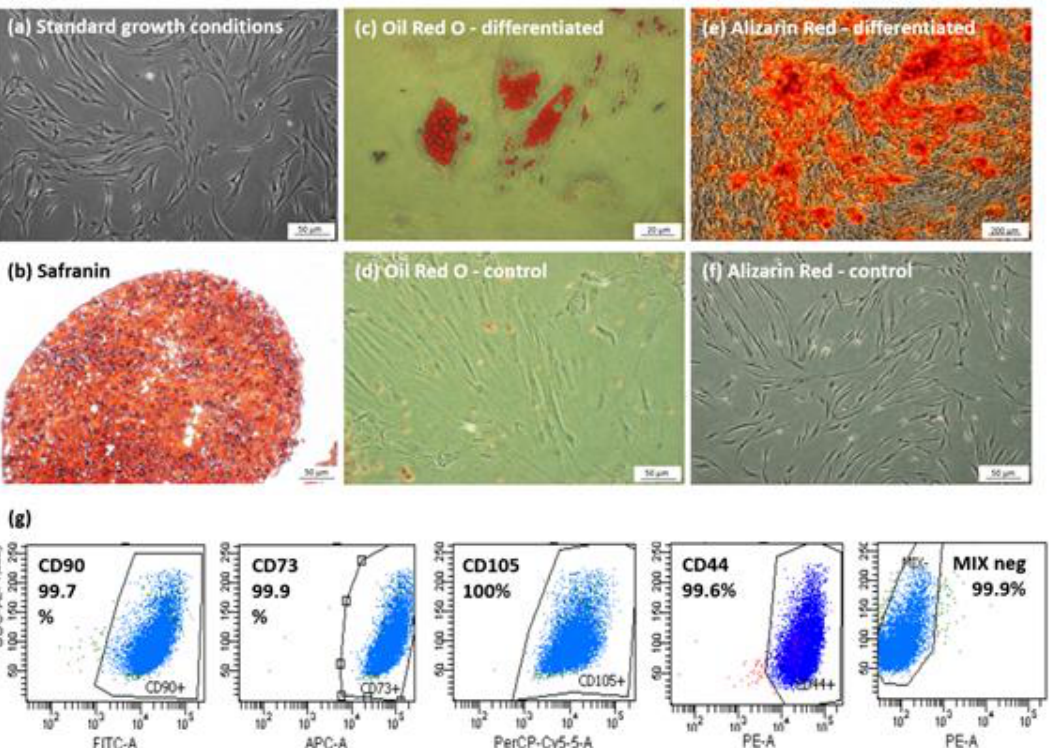
Figure 1. Identification of hBM-MSCs. ( a ) Untreated BM-MSCs during growth phase. Light microscopy; ( b ) chondrogenic differentiation, chondropellet stained with Safranin O; ( c , d ) Oil Red O staining of hBM-MSCs cultured in adipogenic ( c ) or control medium ( d ) (visible fat droplets stained in red); ( e , f ) Alizarin Red staining of BM-MSCs cultured in osteogenic ( e ) or control medium ( f ) (visible red calcium deposits). ( g ) Flow cytometry analysis of surface antigens on representative hBM-MSCs population. MSCs were positive for CD90, CD73, CD105 and CD44. Negative cocktail (MIX neg) consisted of CD34, CD45, CD11b, CD19 and HLA-DR; Scale bars: 50 µ m ( a – d ); 20 µ m ( c ); 200 µ m ( e